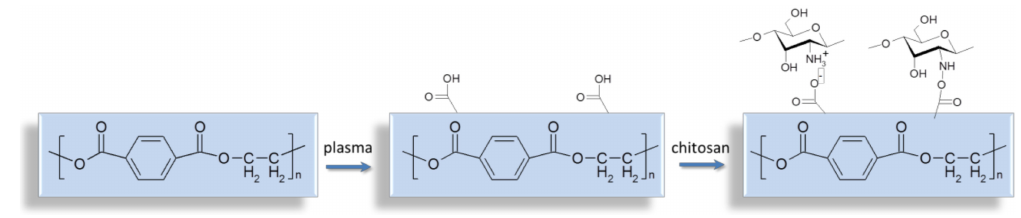
Figure 3. Schema of PET film plasma treatment and chitosan